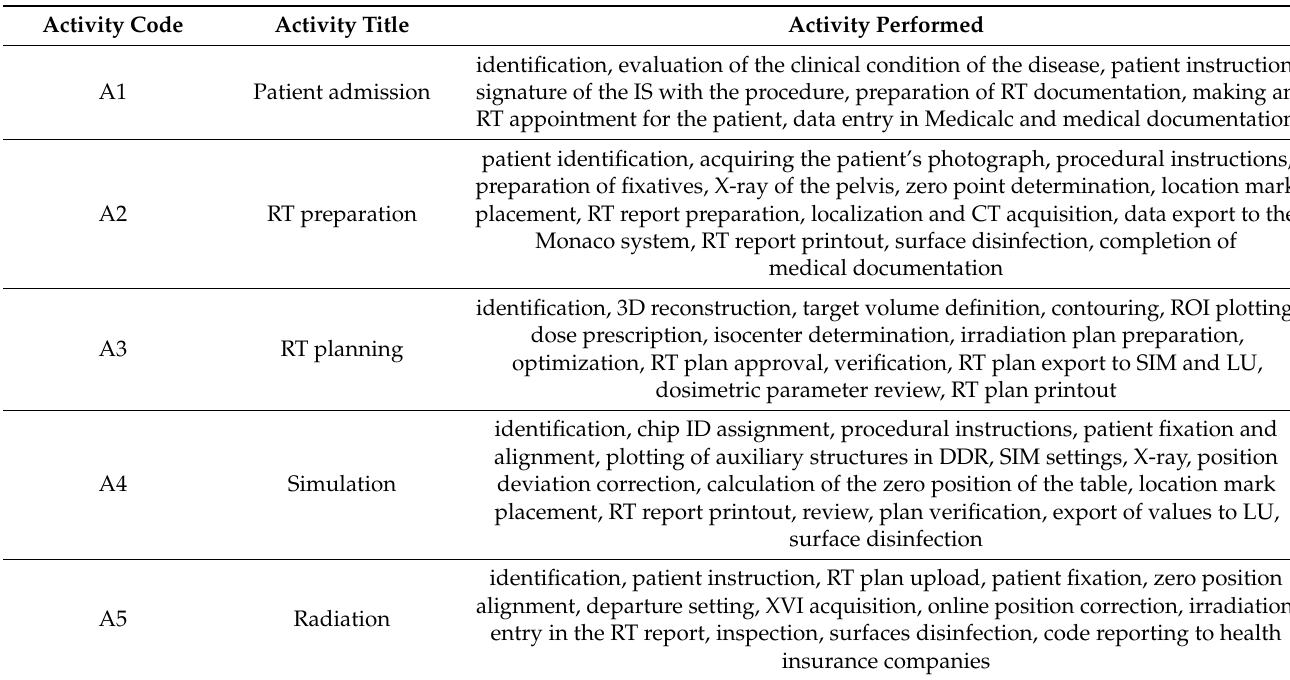
Table 5. Definition of component activities of the treatment